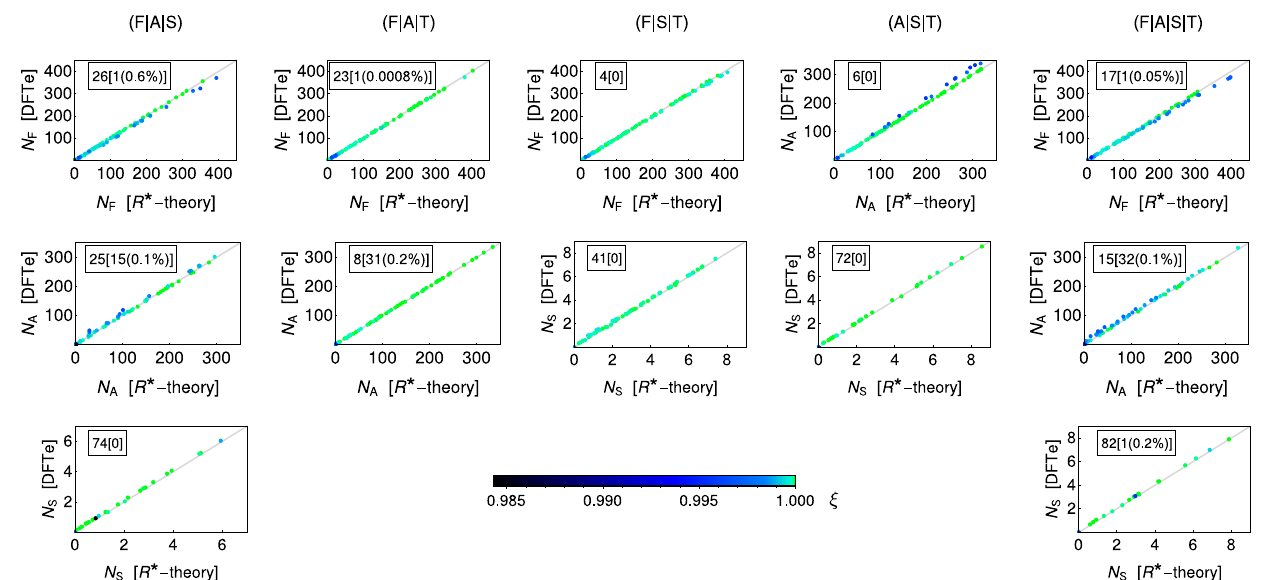
Fig. 3 | An application to Tilman ’ s algae competition experiments demon- strates DFTe ’ s ability to handle resource constraints. Without exception, we found that DFTe delivers the R *-equilibria of (i) the four-species assemblage (F ∣ A ∣ S ∣ T)of Fragilariacrotonensis (F), Asterionellaformosa (A), Synedra fi liformis (S), and Tabellaria fl occulosa (T), and (ii)thethree-speciessubsetsaccurately( ξ ≈ 1;the colour legend applies to all graphs). Each of the fi ve columns of graphs represents 100 randomly drawn resource combinations and shows the resulting DFTe abun- dances N s ( s ∈ {F, A, S, T}; given per micro-litre of suspension) relative to R *-pre- dictions. The DFTe abundances are represented by coloured points, each associated with one resource combination. If both DFTe and R *-theory predict the sameabundanceofoneofthesystem ’ sspecies,thenthecolouredpointfallsonthe